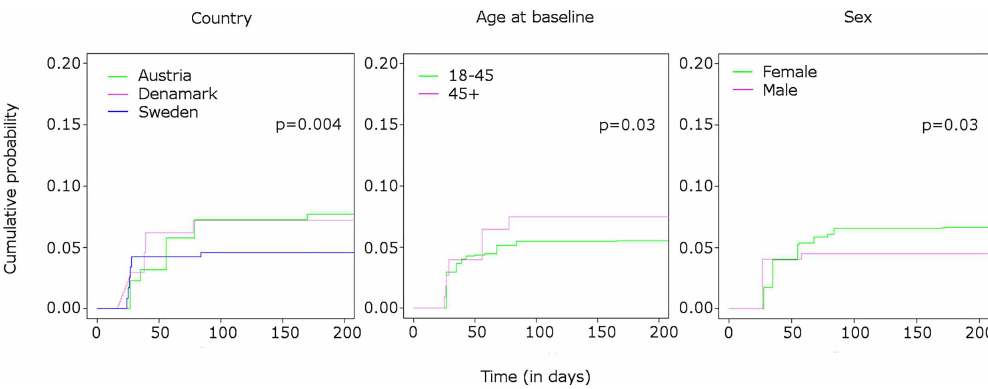
Fig 3. Cumulative probability of developing anti-natalizumab ADA. Estimated cumulative probabilityof developinganti-natalizumab ADA by categoricalvariableswith p-values for rank-based tests adapted for interval censoring.